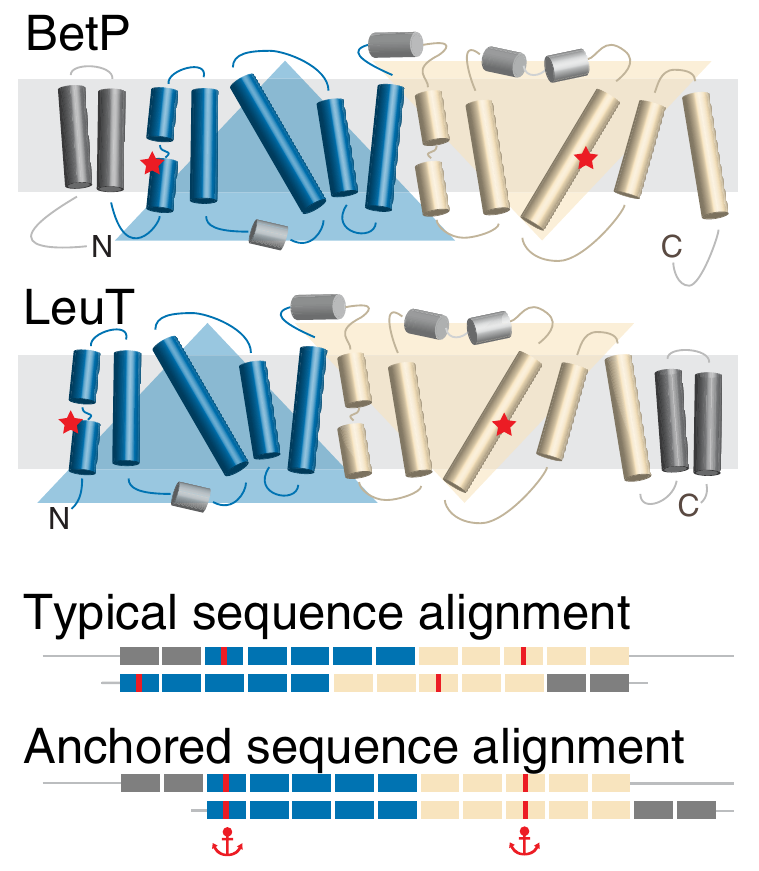
Fig 1. Schematic of the anchors concept as applied to membrane protein sequences. The example is for two proteins with the so-called LeuT fold, which comprises two repeats of five membrane-spanning segments each ( blue and wheat ). The protein BetP differs from LeuT in that it contains two additional transmembrane segments ( dark gray ) at the N-terminal end, rather than at the C-terminal end of the repeats. A typical sequence alignment favors matching of all twelve transmembrane segments and thus incorrectly aligns the core segments, including the position of the sodium binding sites ( red ). These errors can be corrected by using anchors at specific locations, here illustrated by the example of two residues in each protein known, based on biochemical studies, to bind a sodium ion.